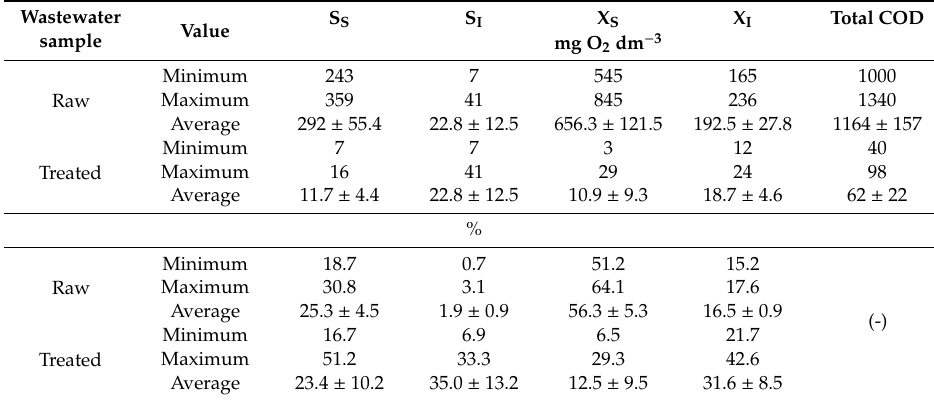
Table 5. COD fractions in raw wastewater and treated wastewater according to the modified ATV-A131 method.